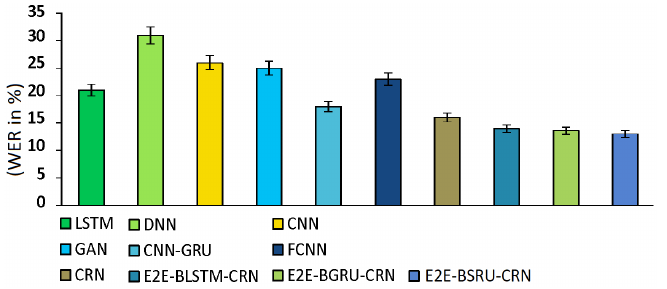
Figure 11. WERs using Google ASR